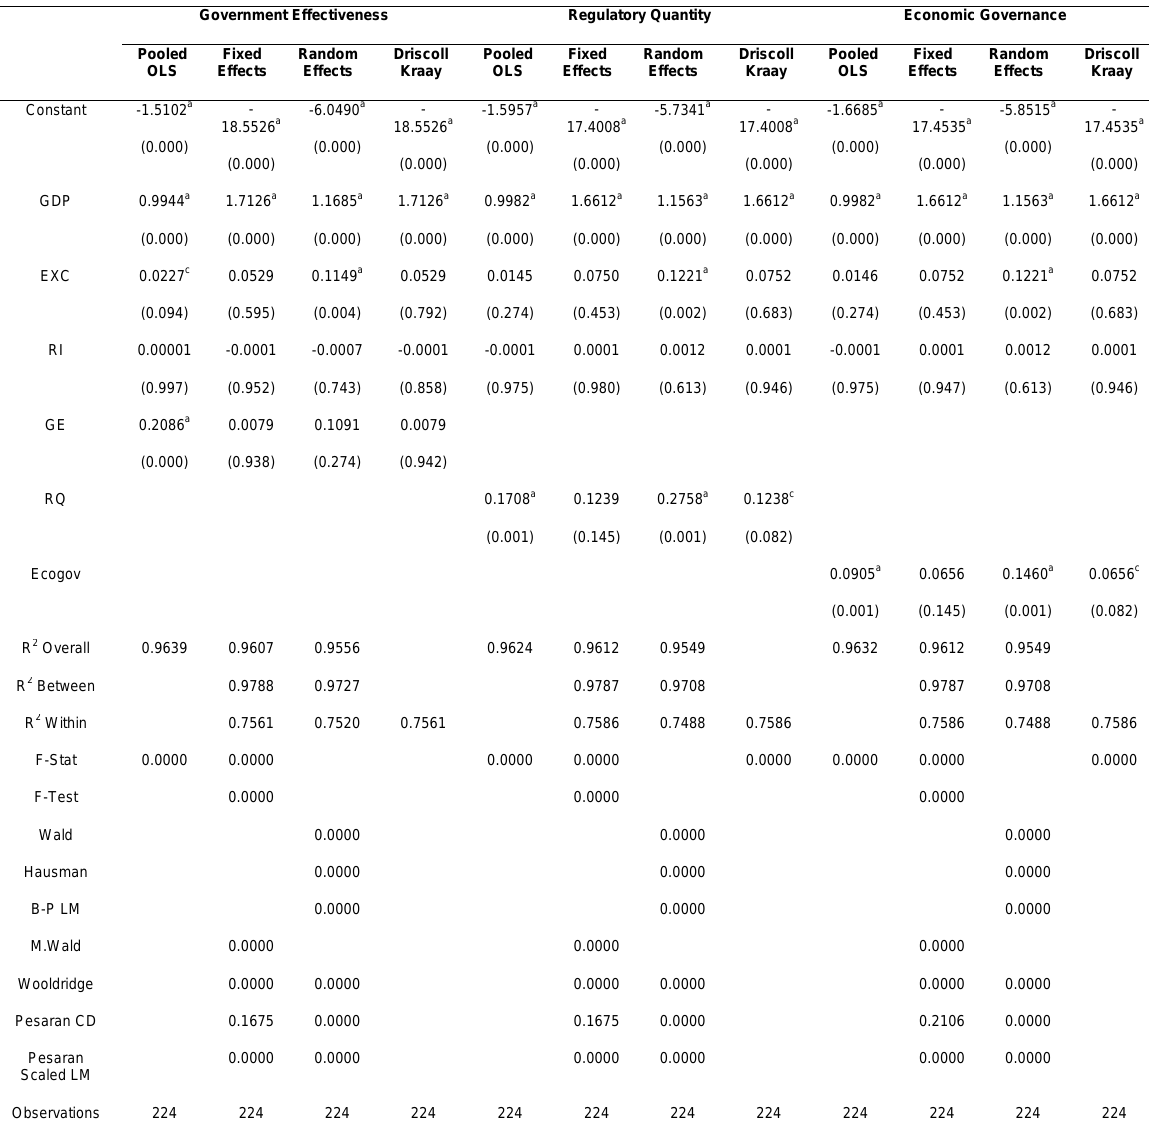
Table 3.5. Economic Governance and Domestic Investment in